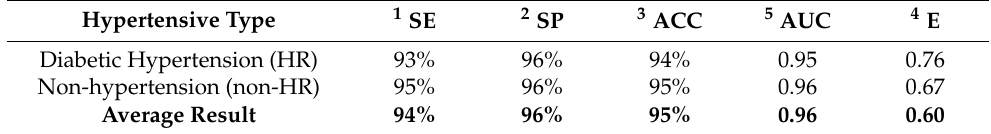
Table 5. Performance evaluation metrics of the implemented CAD-HR system on 9500 retinal